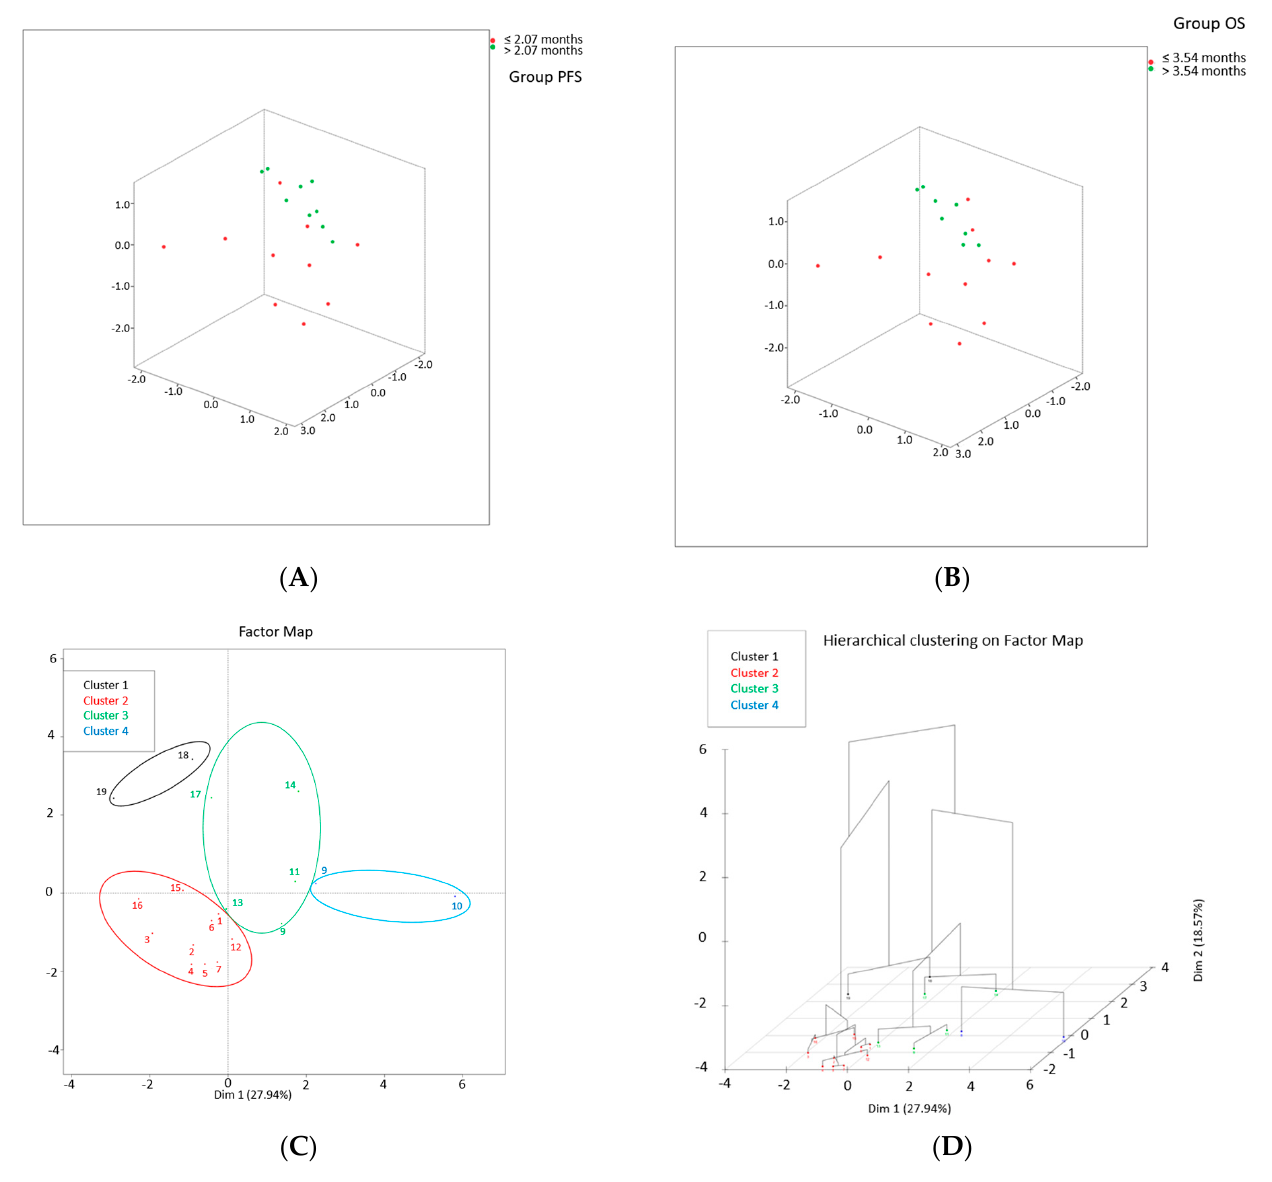
Figure 3. Cluster analysis. ( A ) Tridimensional PCA plot [pts with PFS <= median (red); pts with PFS > median (green)]. ( B ) Tridimensional PCA plot [pts with OS <= median (red); pts with OS > median (green)]. ( C ) Factor map of K-means cluster and ( D ) HCPC 3D dendrogram showing the 4 clusters of pts (cluster 1: black; cluster 2: red; cluster 3: green; cluster 4: blue).